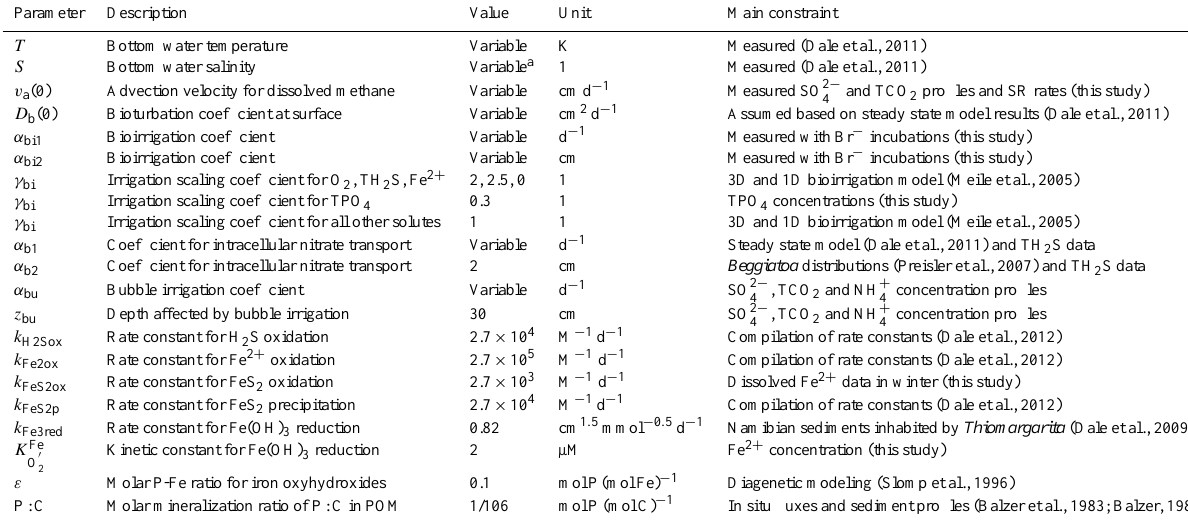
Table 3. Important parameters used in the biogeochemical model. Time-dependent parameters denoted “variable” are shown in Fig. 2. All other parameters are listed in the